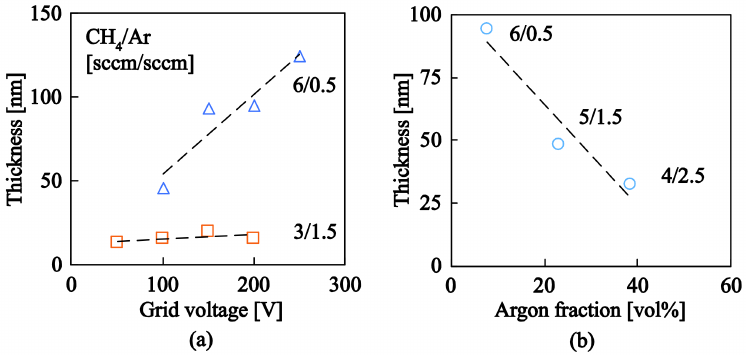
Figure 2. ( a ) Effect of grid voltage on film thickness for two different gas flow rate combinations: CH 4 /Ar = 6.0 sccm/0.5 sccm = 12 and CH 4 /Ar = 3.0 sccm/1.5 sccm = 2; results are for RF power of 200 W; ( b ) Effect of volume fraction on film thickness; results are for RF power of 200 W and grid voltage of 150 V and a constant total gas flow rate in the chamber (CH 4 + Ar = 6.5 sccm).